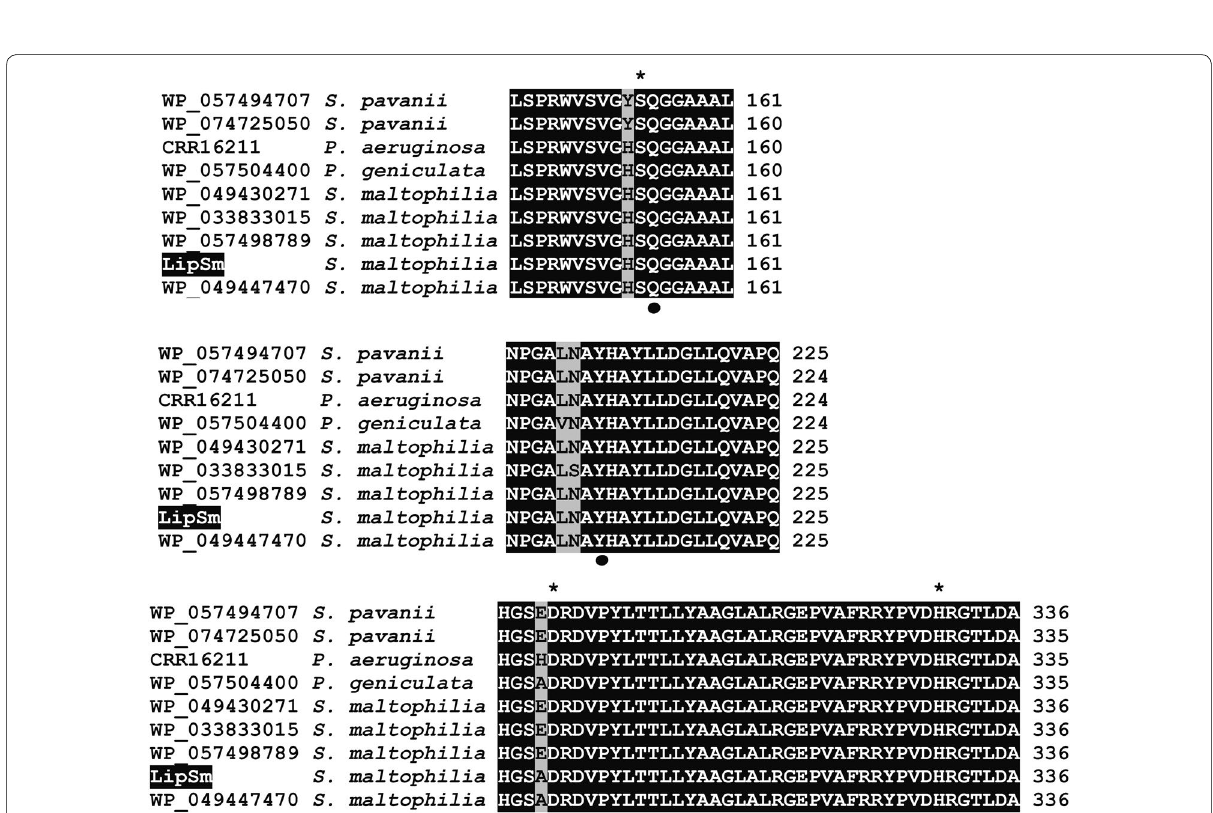
Fig. 4 Blocks of conserved sequences amongst LipSm and other members of novel family XVIII. Identical and equivalent amino acids are on black or grey background, respectively. Stars and dots indicate amino acid residues constituting the catalytic triad and oxyanion hole,